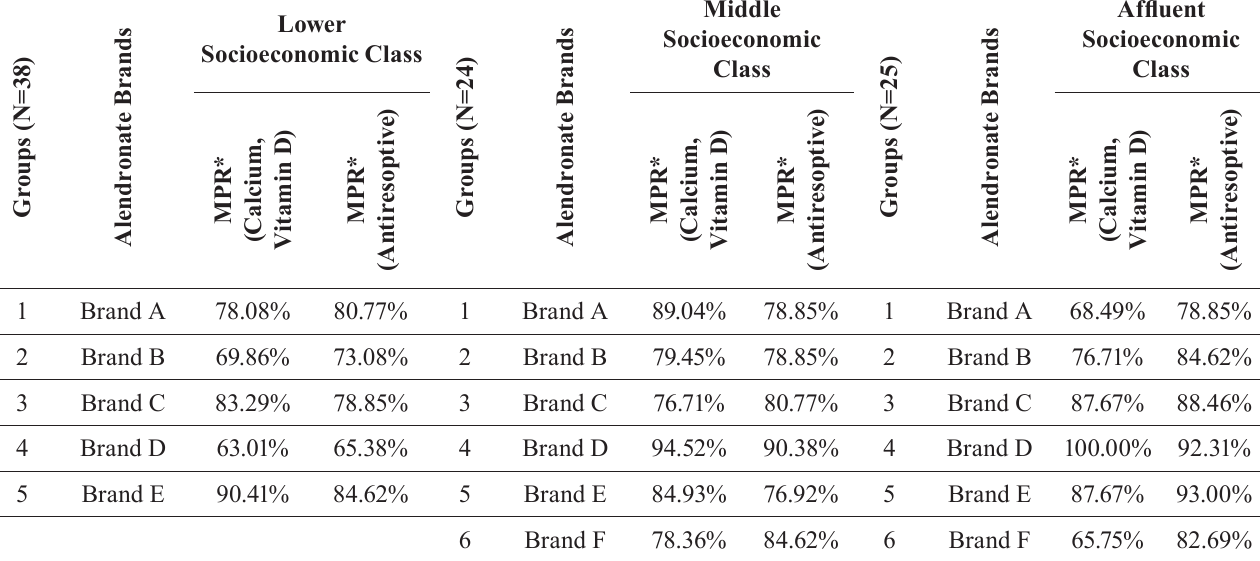
TABLE V - M PR of Alendronate Brands, Calcium, Vitamin D in different Socioeconomic Classes